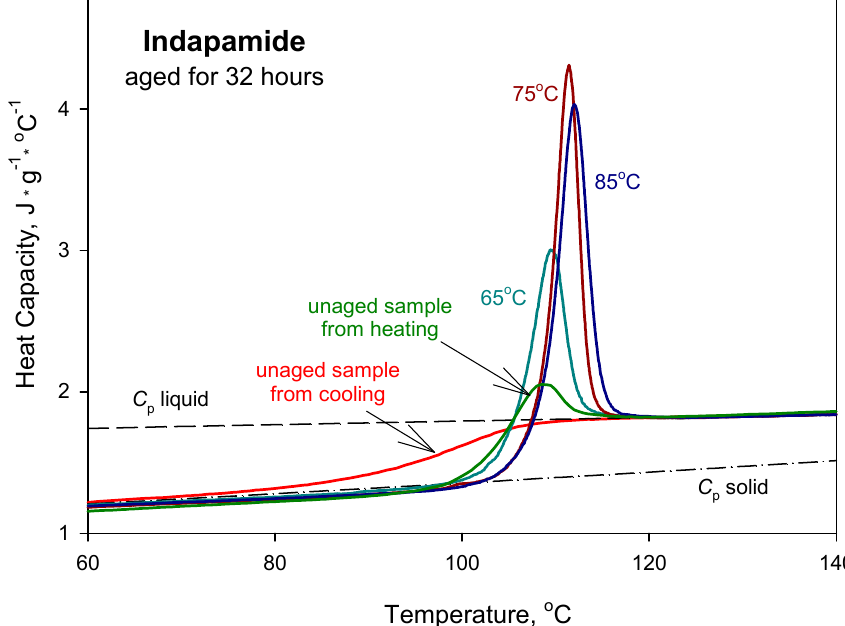
Figure 5. Experimental heat capacity as a function of temperature for amorphous IND aged isothermally at 65, 75 and 85 ◦ C for 32 h, together with the solid heat capacity C p (solid) and liquid heat capacity C p (liquid) as reference lines [47]. C p of the unaged sample was obtained during cooling (red line) from the molten state and heating (green line) after cooling from the melt. Scans were recorded with a